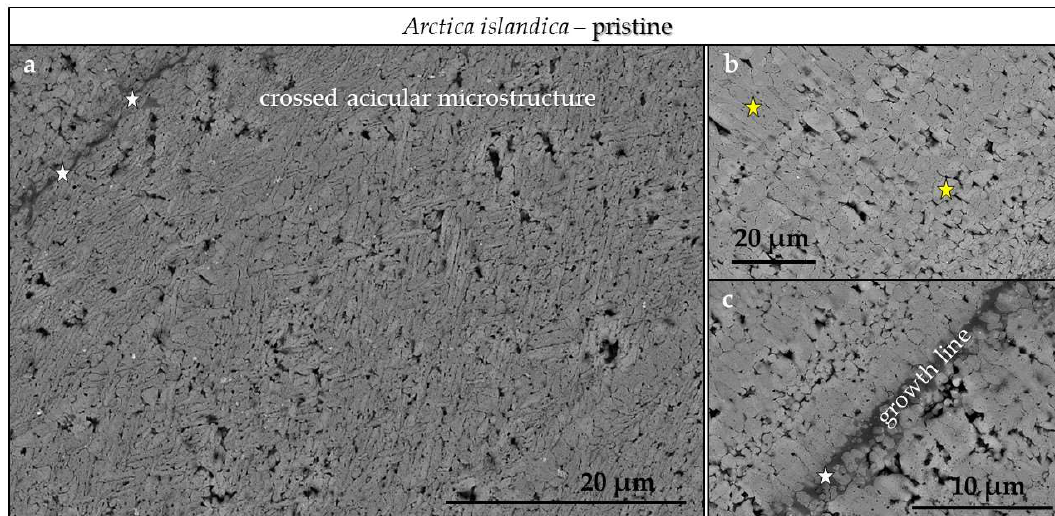
Figure A7. FE-SEM images of ( a ) the shell microstructure of pristine Arctica islandica ; ( b , c ) variation in size and morphology of constituting mineral units and presence of growth lines (white stars in ( a , c ) distinguished by an increased amount of biopolymer content.